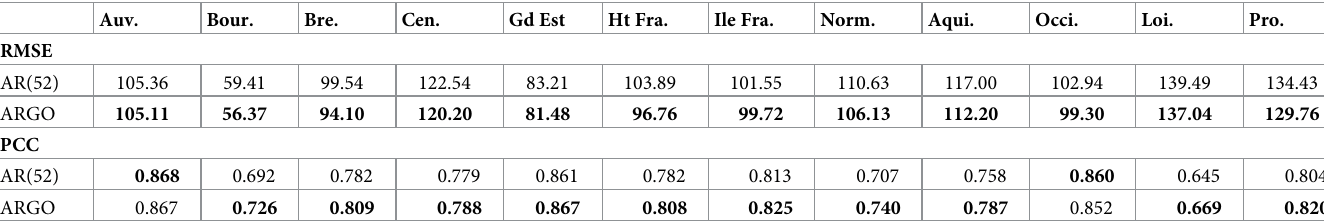
Table 5. One-week ahead estimate—RMSE and PCC for ARGO models including only historical data (AR(52)) and only climatic data, for the period starting from January 2015 to March 2017. Auv. Bour. Bre. Cen. Gd Est Ht Fra. Ile Fra. Norm. Aqui. Occi. Loi. Pro. RMSE AR(52) 105.36